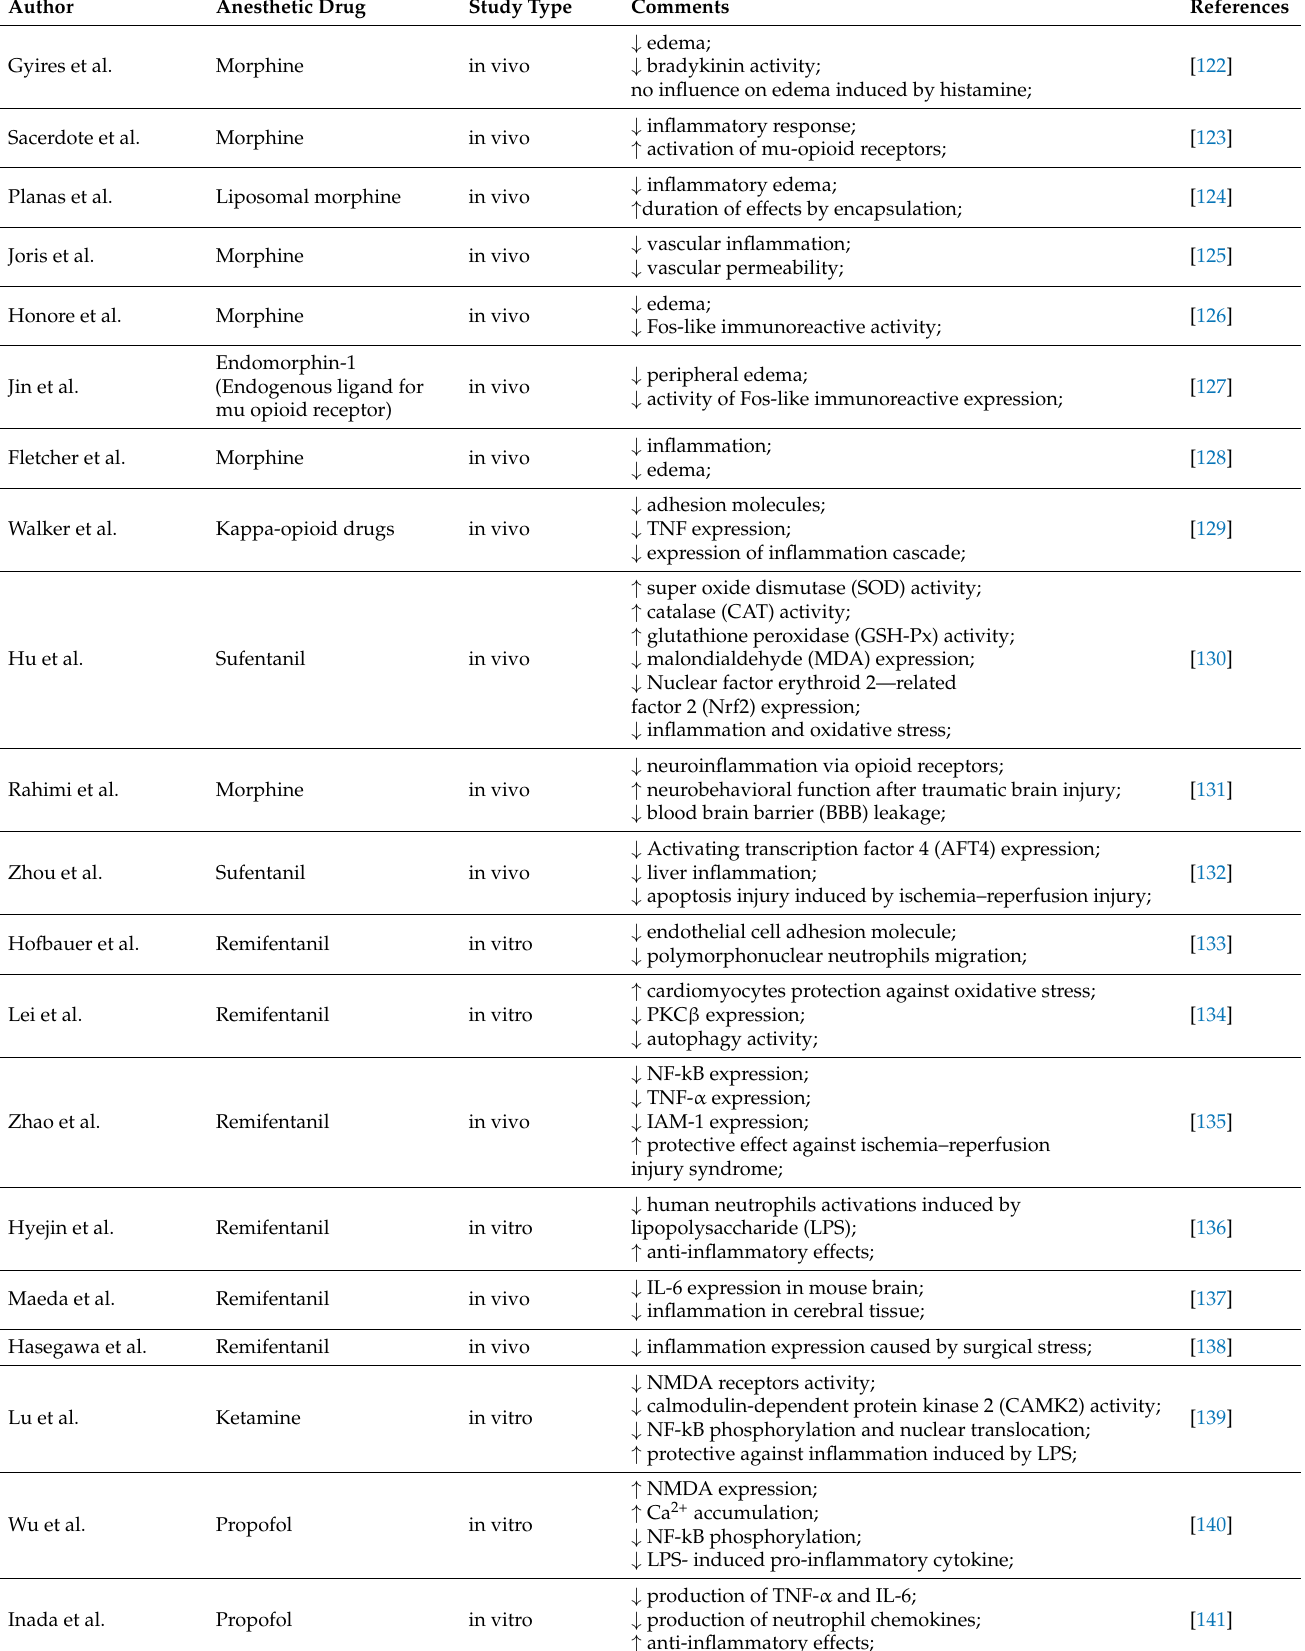
Table 1. The impact of anesthetic drugs on inflammatory expression and cellular pathways